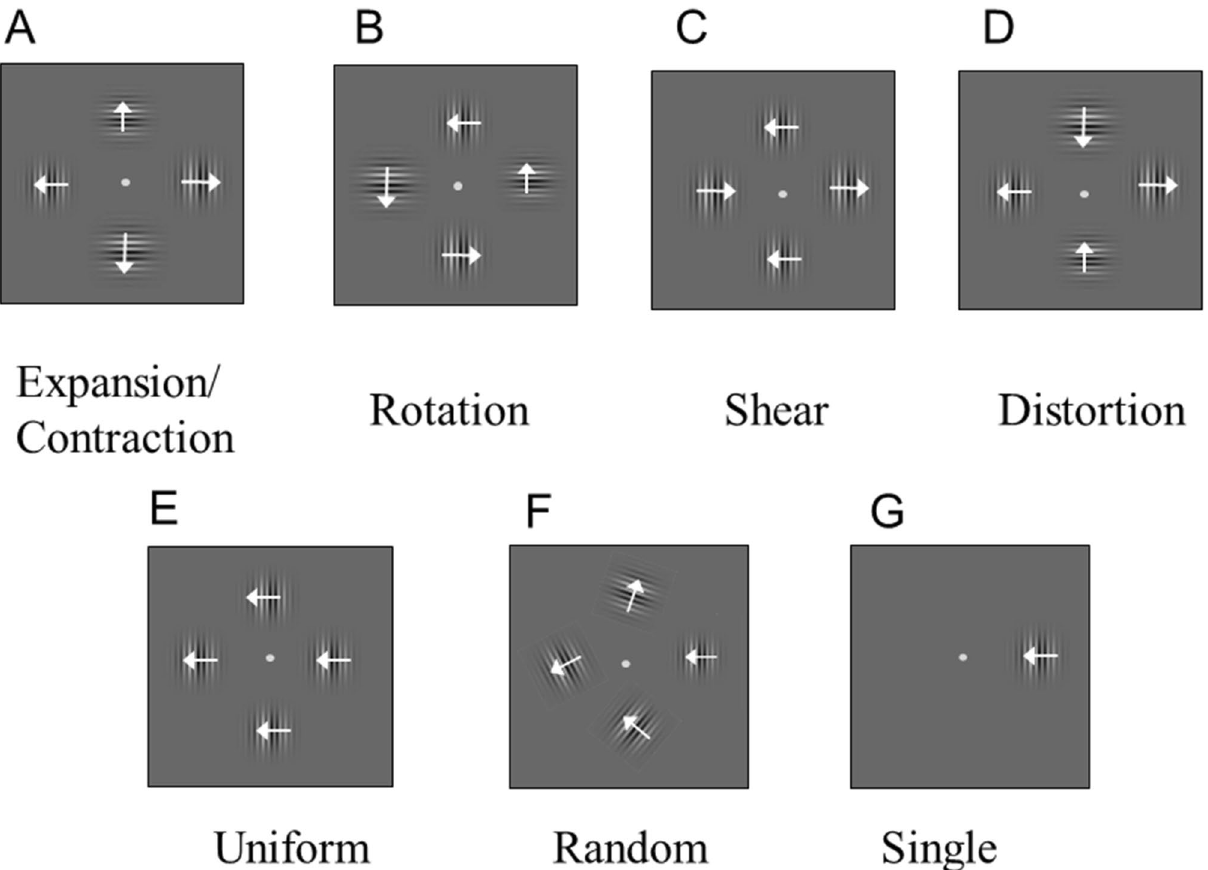
Figure 2. Adaptation stimuli in Experiment 1. The arrows showed the motion directions of the 0.53 cpd grating and the components of 2.13 cpd drifted in opposite directions or vise versa. ( A ) Expansion/ Contraction Condition: four identical compound motion Gabor patches drifted away from the center (thus creating an expansion, as shown by the arrows) or toward the center (thus creating a contraction motion). ( B ) Rotation Condition: four compound motion Gabor patches with different drifting directions in a circular arrangement when a global rotational motion (counter-clockwise as shown by the arrow) was perceived. ( C ) Shear Condition: The top and bottom Gabor patch pair moved in opposite directions to the left and right Gabor patch pair. ( D ) Distortion Condition: The two vertical Gabor patches move toward the center while the two horizontal Gabor patches move away from the center. ( E ) Uniform Motion Condition: all four Gabor patches move in the same direction. ( F ) Random Motion Condition: the four Gabor patches drift in no systematically defined directions except that one patch moved horizontally so that the MAE direction was either left or right. The other three moved in directions randomly selected from angles between 30 and 330 degrees with a separation of 30 degrees from trial to trial. We regenerate the stimulus in the cases that the arrangement resembled any of the other types of arrangement. ( G ) Single element condition: A single Gabor patch was presented at the right of the fixation and it moved